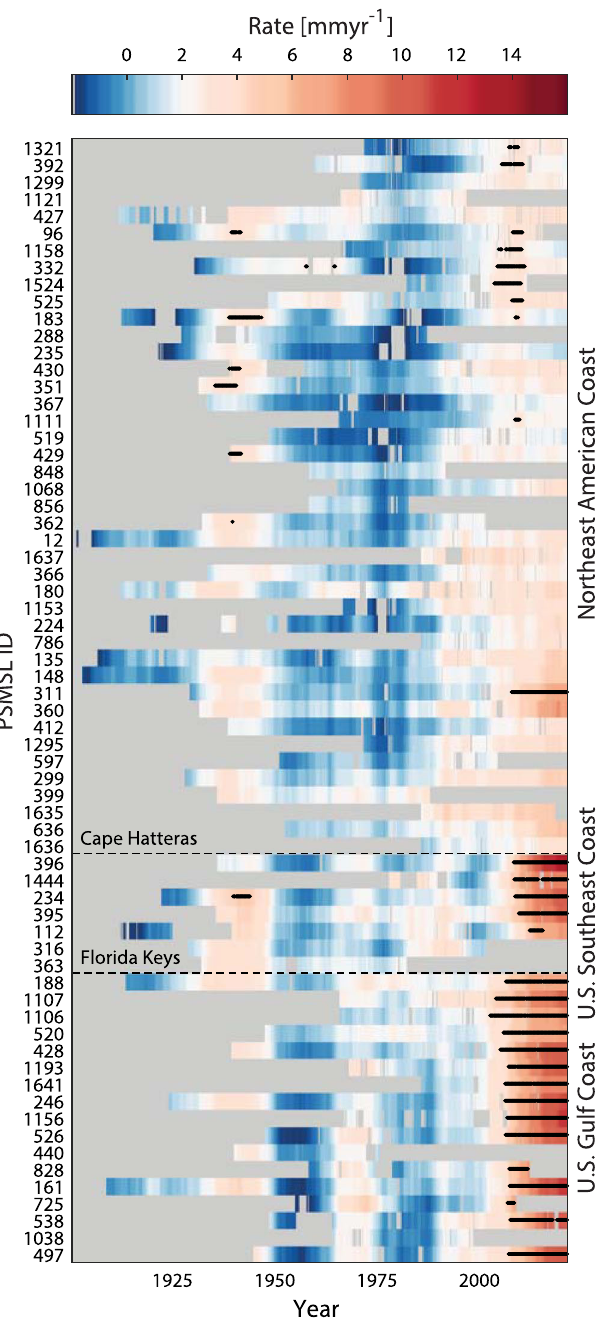
Fig. 2 | Rates of mean sea level (MSL) rise along the North American East and Gulf coastsince 1900. Color shadings represent the rates of(vertical land motion corrected)MSLwithtidegaugesarrangedfromTexastoNewfoundland(bottomto top)followingthecoastline.Ratesthatrepresentasigni fi cantaccelerationfromthe mean rate are marked with black dots. The two dashed lines mark Cape Hatteras and the Florida